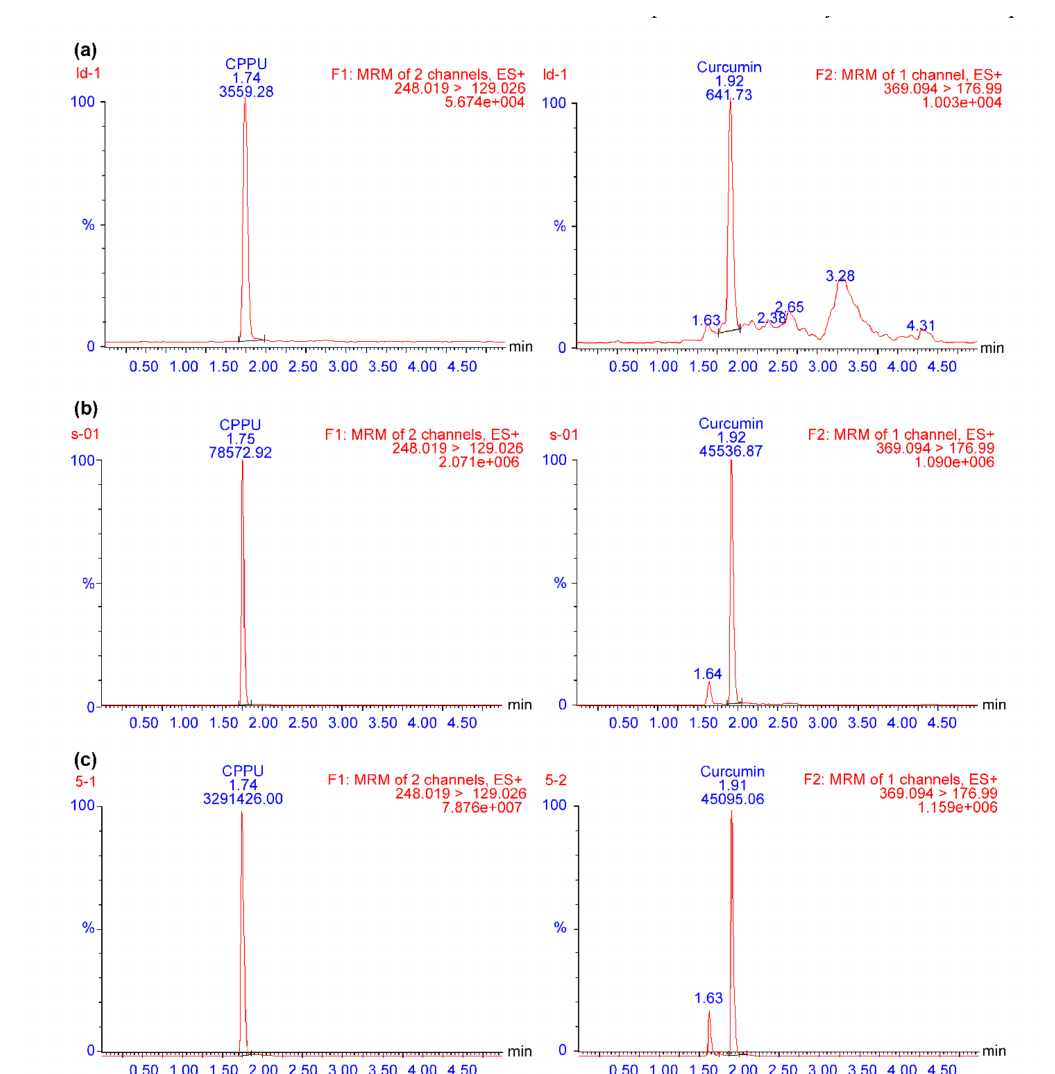
Figure 1. Typical LC/MS-MS chromatograms of ( a ) blank plasma, ( b ) blank plasma spiked with CPPU at the LLOQ, and ( c ) actual sample obtained from a rat 0.5 h after intragastric administration of CPPU. CPPU—1-(2-chloro-4-pyridyl)-3-phenylurea, forchlorfenuron; LC/MS-MS—liquid chromatography-mass spectrometry; LLOQ—lower limit of